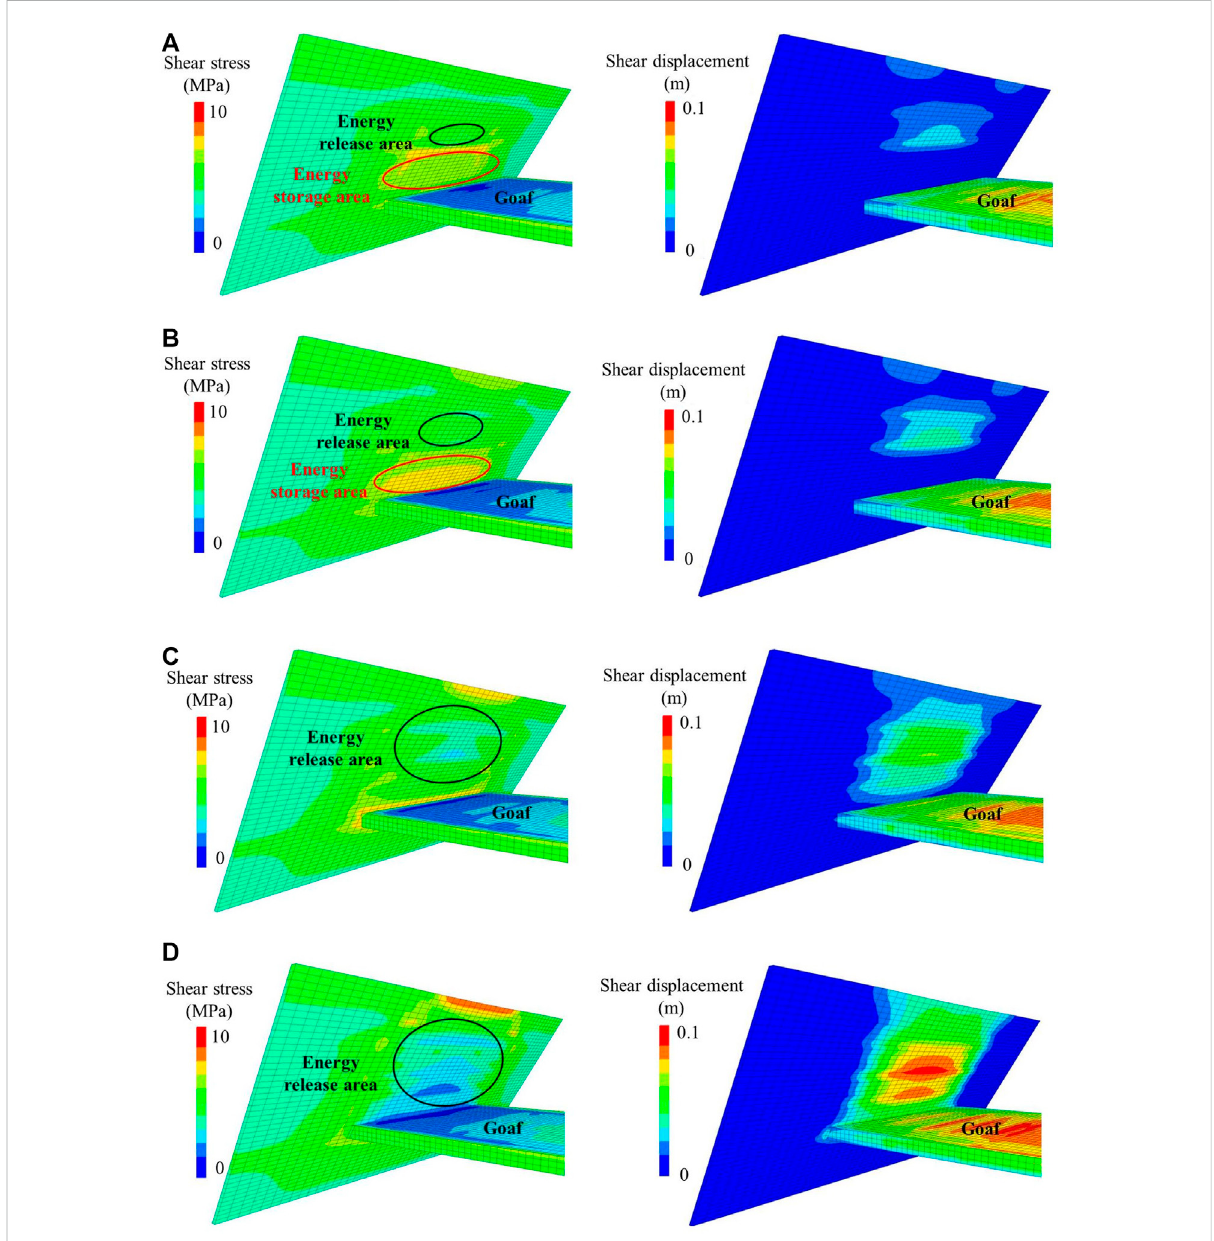
FIGURE 10 Shear stress and shear slip of the fault when mining the panel to different positions. (A) The working face is 30 m away from the fault. (B) The working face is 20 m away from the fault. (C) The working face is 10 m away from the fault. (D) The working face is 0 m away from the